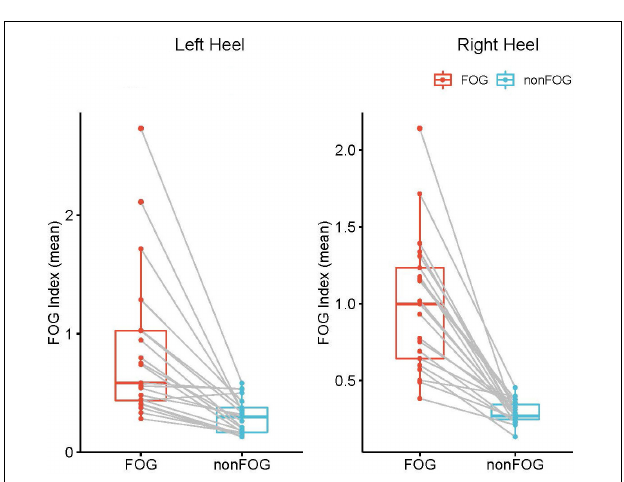
FIGURE 4 | Statistical comparison of the FI between freezing the non-onset period at trial level. Each red data point represents the FI during the FOG of a walking trial, and blue data point represents the FI during the non-FOG of a walking trial. FI during FOG is significantly higher than effective walking period. Both sides exhibited similar results ( P